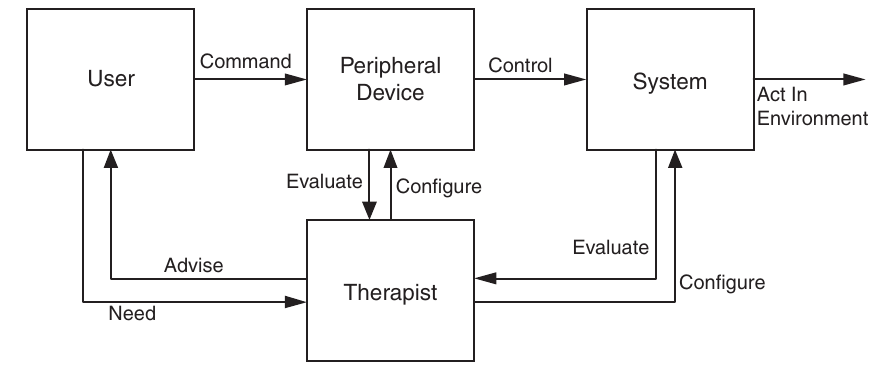
Fig. 1. Strategy for a normal therapy